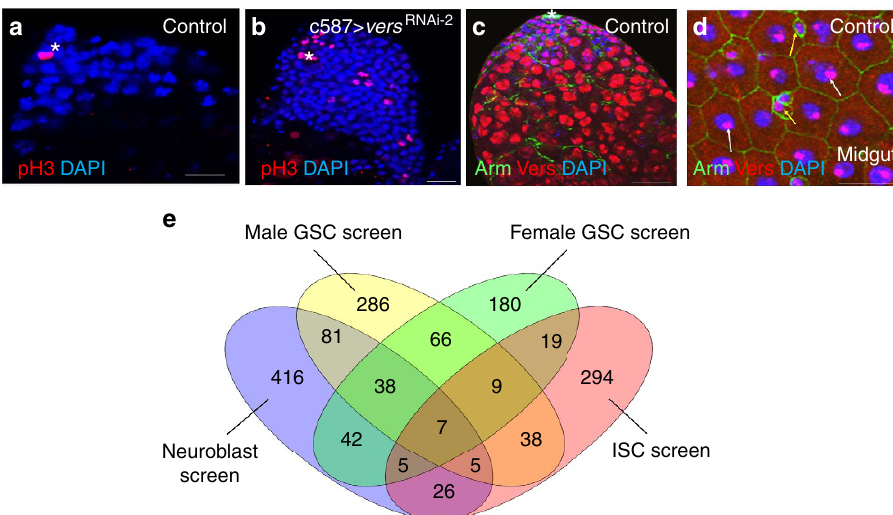
Figure 6 | Cell proliferation in vers knockdown and Vers expression. ( a ) Wild-type (control) testis. ( b ) Knockdown of vers in the CySC lineage ( c587-Gal4 ) resulted in an expansion of mitotic cells. Vers expression in the testis ( c ) and in the midgut ( d ). ( e ) Comparison of male GSC, ISC, neuroblast and female GSC RNAi screens. Number of genes identified in the male GSC, ISC, neuroblast and female GSC screens. Seven genes were found in all four screens; 9 genes were shared by male GSC, female GSC and ISC screens; and 38 genes were shared by male GSC, female GSC and neuroblast screens. Venn diagram was prepared from: http://bioinfogp.cnb.csic.es/tools/venny/index.html. Testes of the indicated flies were dissected, stained with the antibodies to phospho-Histone 3 (pH3) (red, marks mitotic cells) ( a , b ), Vers (red, all type of cells in the testis and midgut), Arm (green, hub cells in testis ( c ) and epithelial membrane in the midgut ( d )) and DAPI (blue, marks the nuclei), and analysed by confocal microscopy. Asterisks indicate hub cells. Yellow arrows in d indicate ISC/EB (enteroblast) cells and white arrows indicate enterocyte (EC) cells. The flies were cultured at 29 (cid:2) C for 7 days in a – d . Scale bars, 10 m